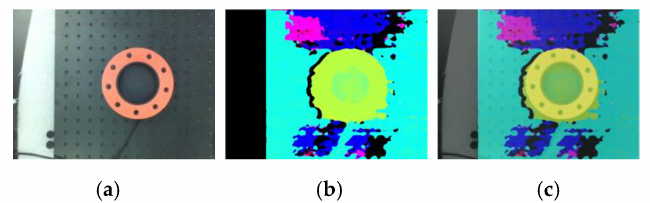
Figure 14. The disparity image of a pipe joint: ( a ) original image; ( b ) disparity map; and ( c ) superim- posed